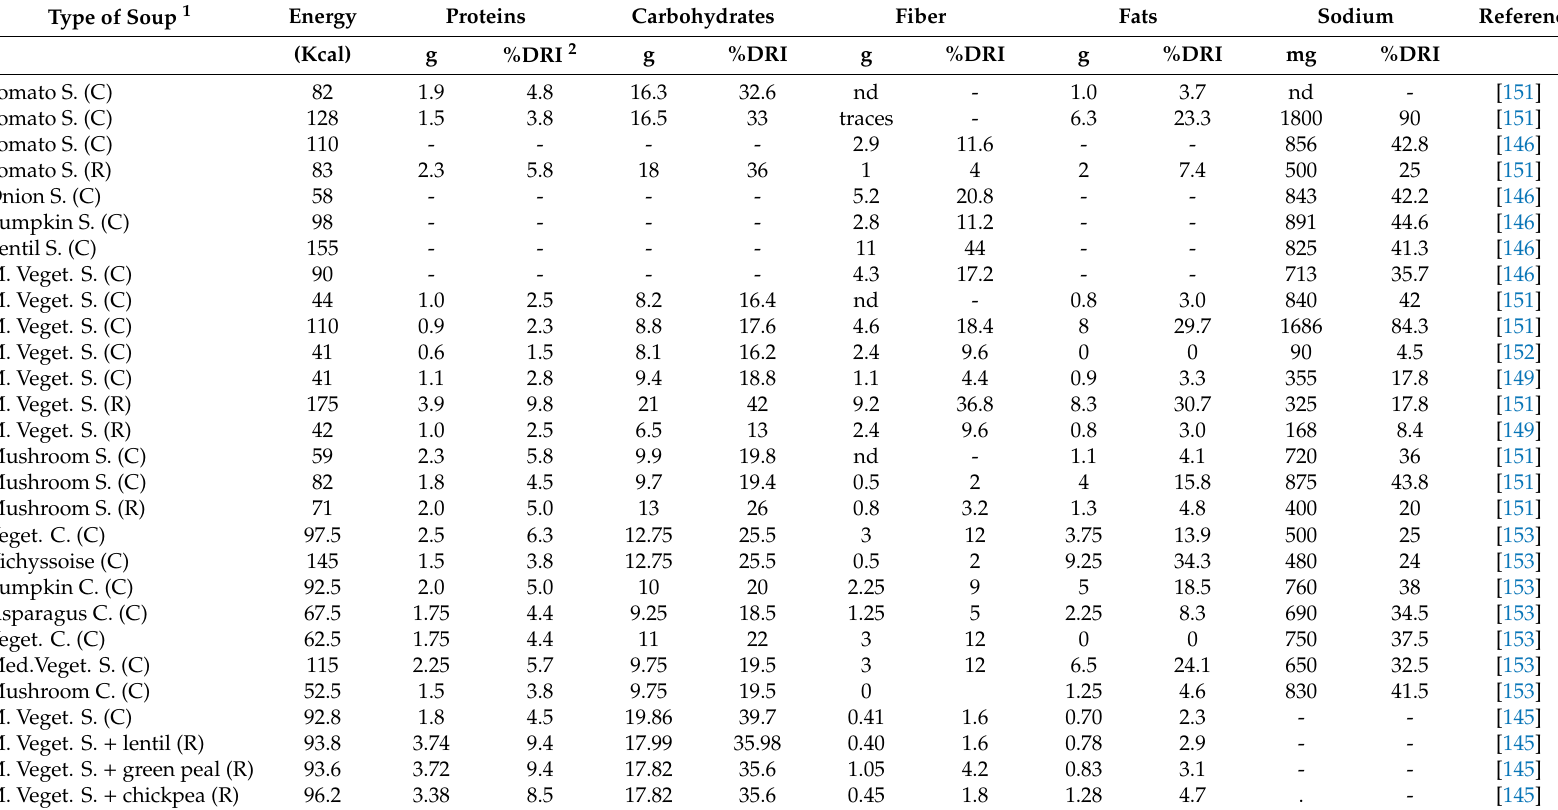
Table 1. Nutrient content of commercial (C) and reformulated (R) vegetable soups (per 250 mL